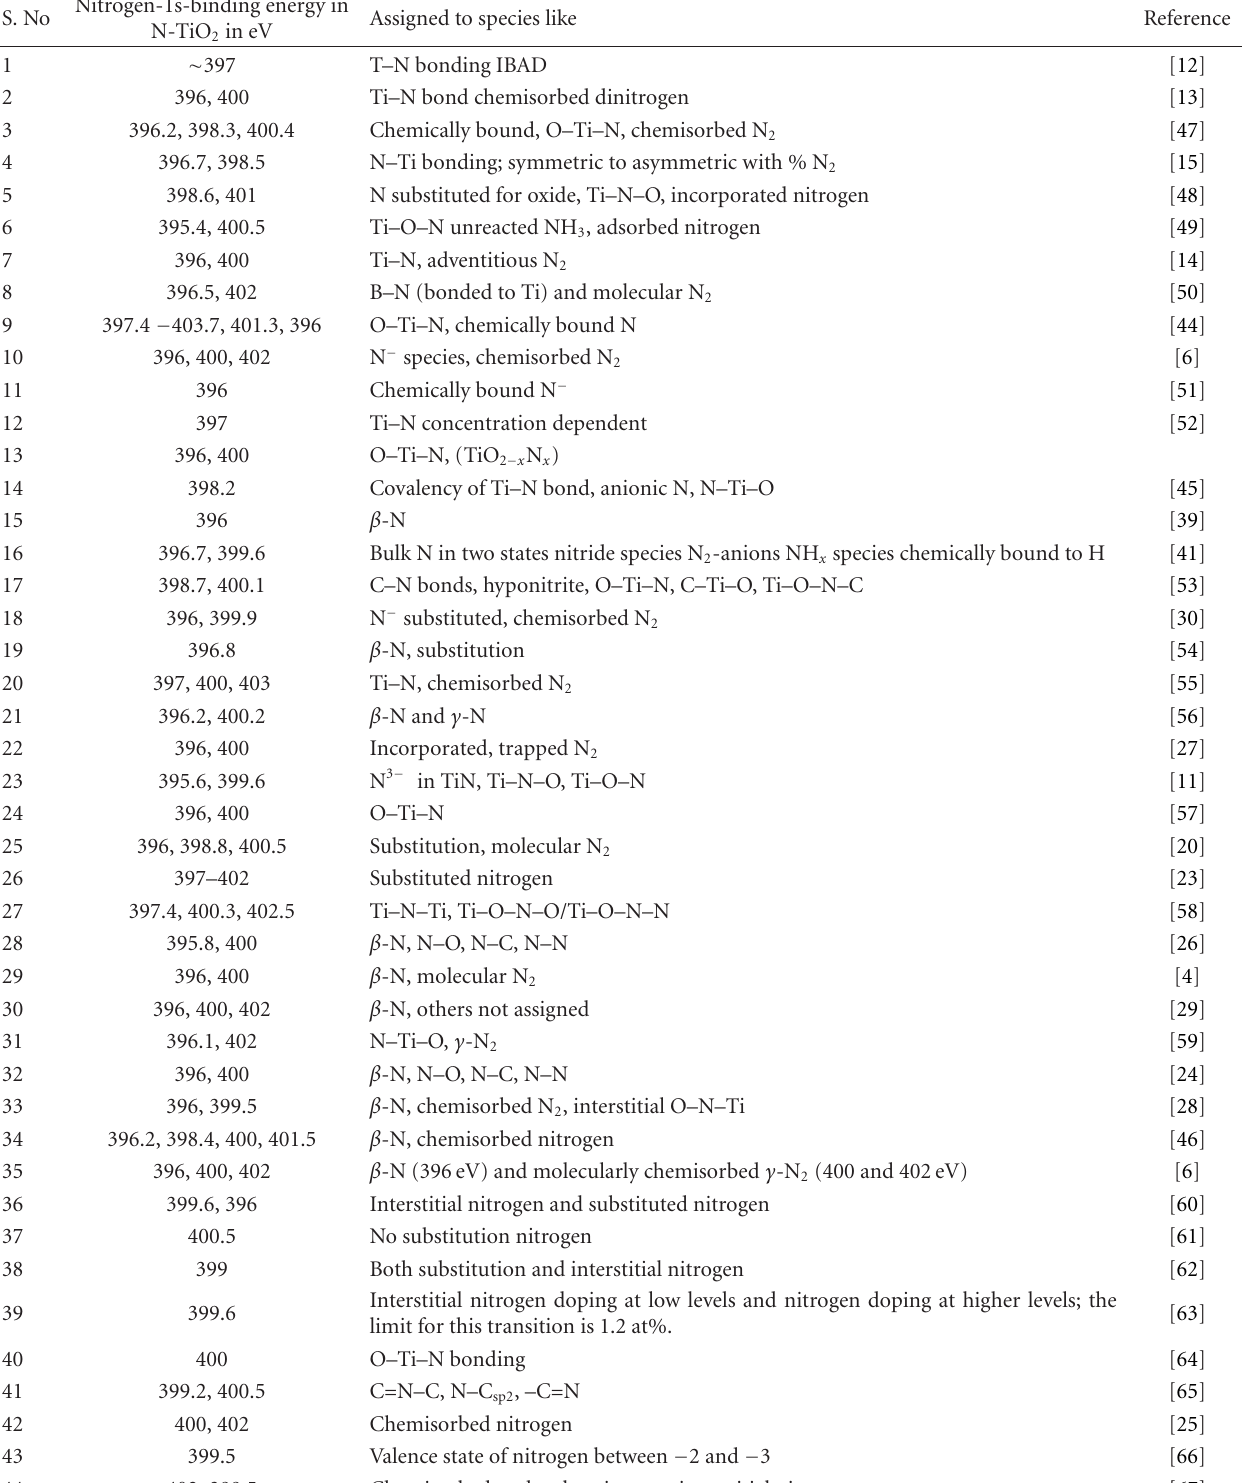
Table 1: Nitrogen-1s-binding energies in nitrogen substituted TiO 2